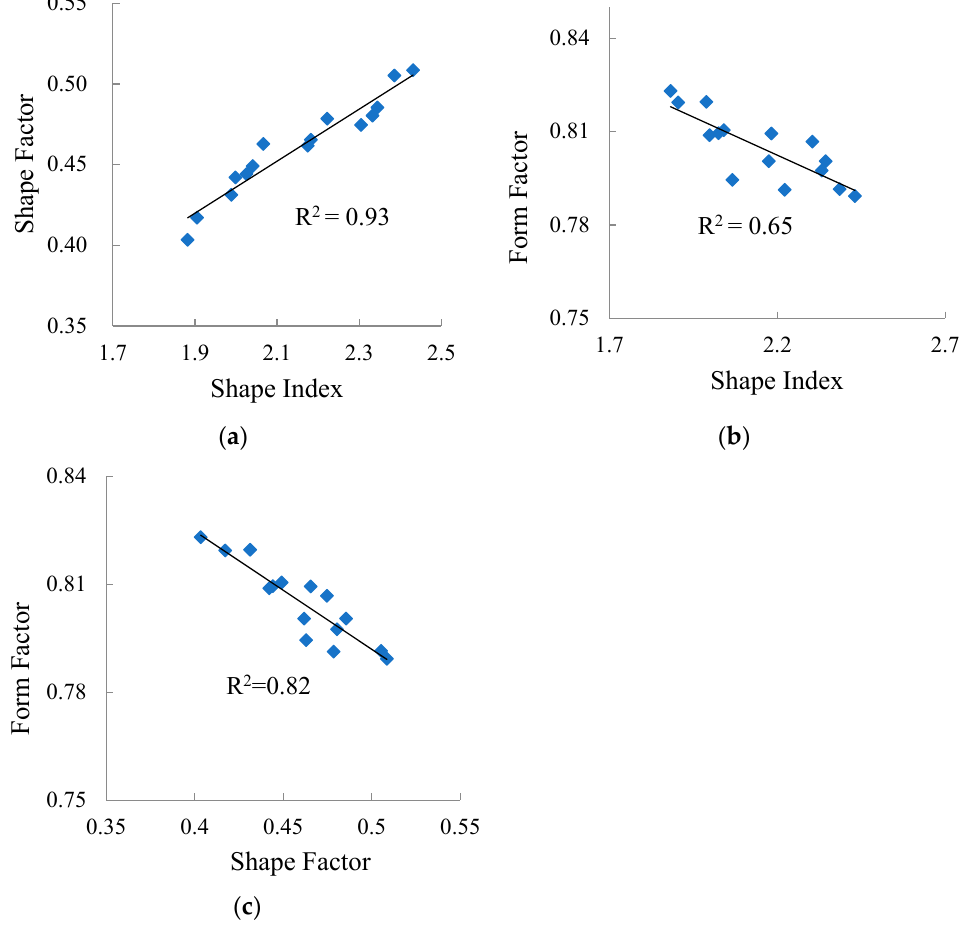
Figure 8. Correlation between aggregate form evaluation indices: ( a ) Shape index and shape factor, ( b ) Shape index and form factor, ( c ) Shape factor and form factor.